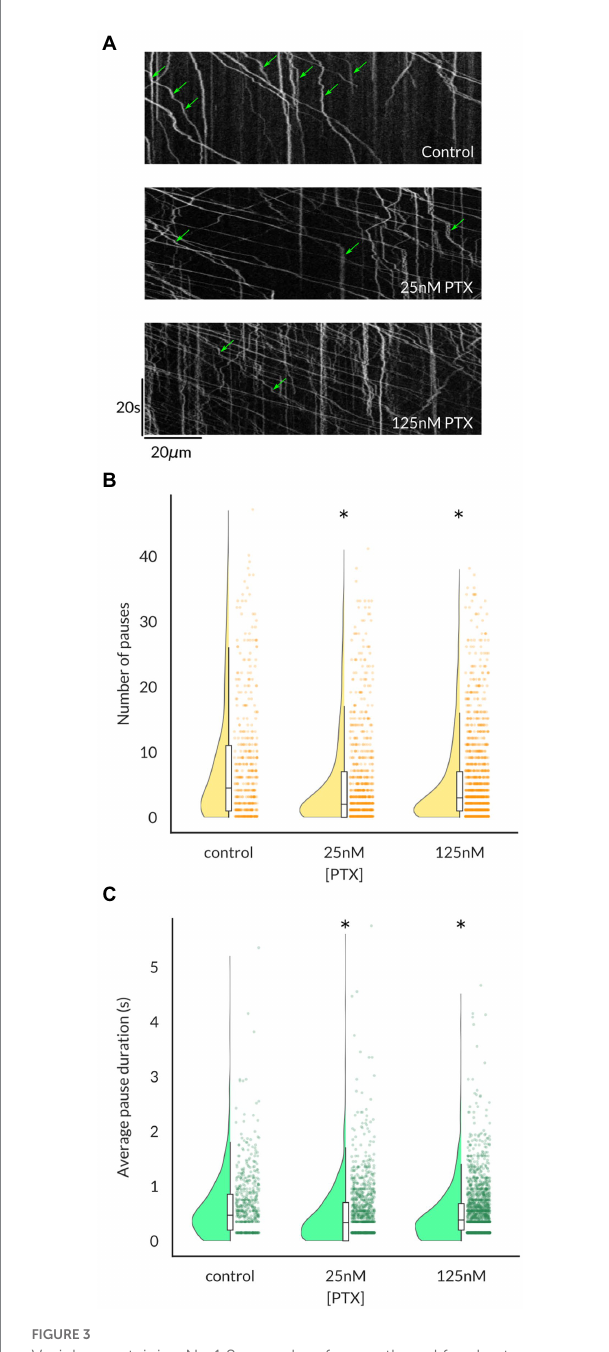
FIGURE 3 Vesicles containing Na V 1.8 pause less frequently and for shorter durations following paclitaxel treatment of DRG neurons. (A) Kymographs show the position of fluorescent vesicles along the trajectory of an axon (x-axis) as a function of time (y-axis). Stationary periods (green arrows) appear as vertical lines, which decrease both in frequency (B) and average duration (C) under PTX treatment. Each point in (B , C) represents an individual vesicle and at least 3 independent cultures were analyzed per condition ( * all p < 7.6 × 10 − 5 by Mann– Whitney U test corrected for multiple comparisons).